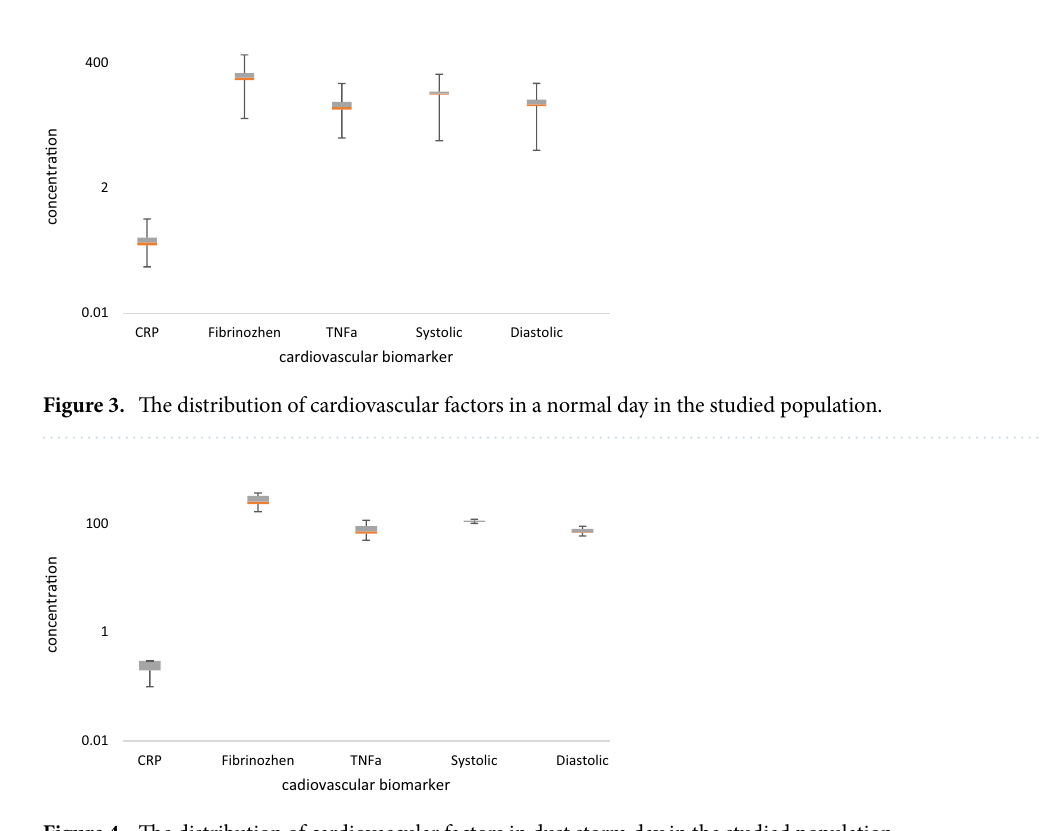
Figure 4. The distribution of cardiovascular factors in dust storm day in the studied